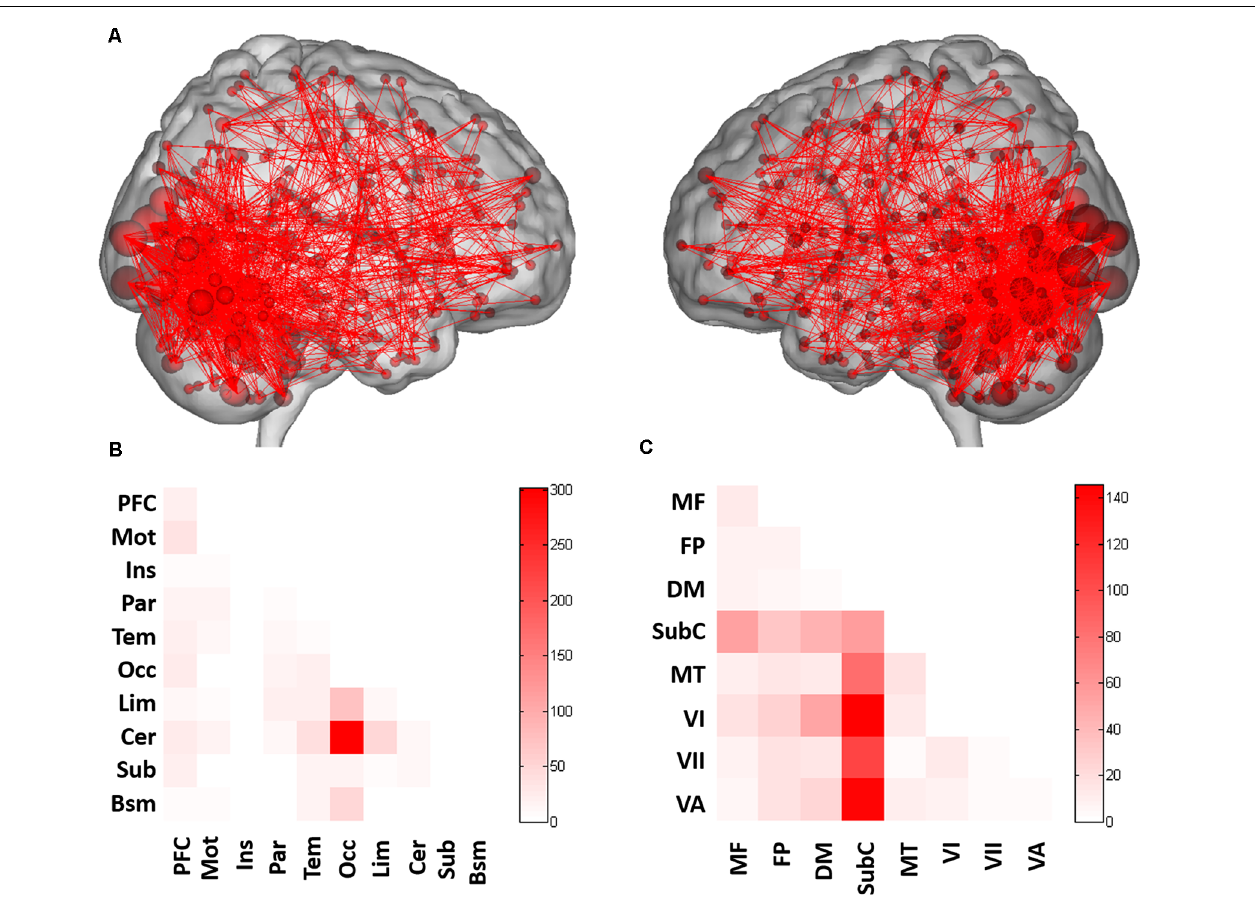
FIGURE 2 | Functional connections predicting CAPS-IV scores. (A) Positive (red) networks selected by the prediction model. For the positive network, increased edge weights (i.e., increased functional connectivity) predict higher CAPS-IV scores. (B) Connections plotted as number of edges within and between each pair of macroscale regions. (C) Connections plotted as number of edges within and between each pair of canonical networks. Cells represent the total number of edges connecting nodes within (and between) each macroscale region or canonical network, with darker colors indicating a greater number of edges. PFC, prefrontal; Mot, motor; Ins, insula; Par, parietal; Tem, temporal; Occ, occipital; Lim, limbic; Cer, cerebellum; Sub, subcortical; Bsm, brainstem; MF, medial frontal network; FP, frontoparietal network; DM, default mode network; SubC, subcortical-cerebellum network; MT, motor network; VI, visual I network; VII, visual II network; VA, visual association network.